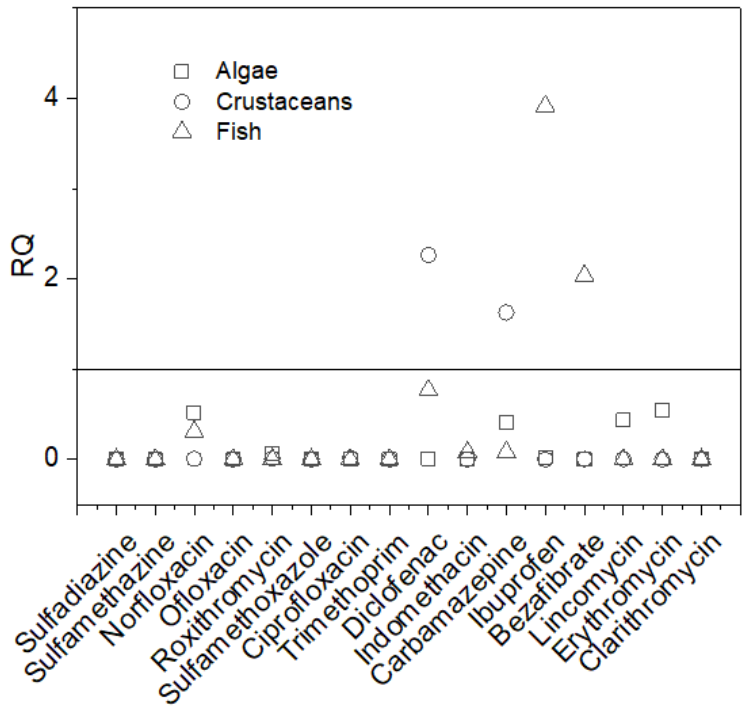
Figure 3. The RQs of PPCPs in the Daqing River Basin.